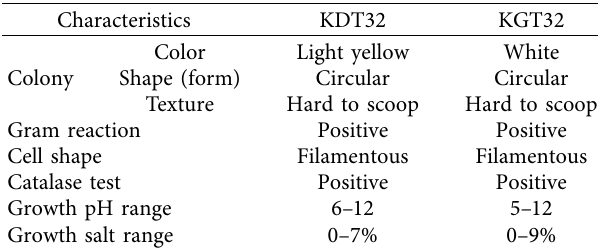
Figure 7: The morphology and catalase activity of KDT32 and KGT32 isolates. Table 2: The phenotypic characterization of KDT32 and KGT32